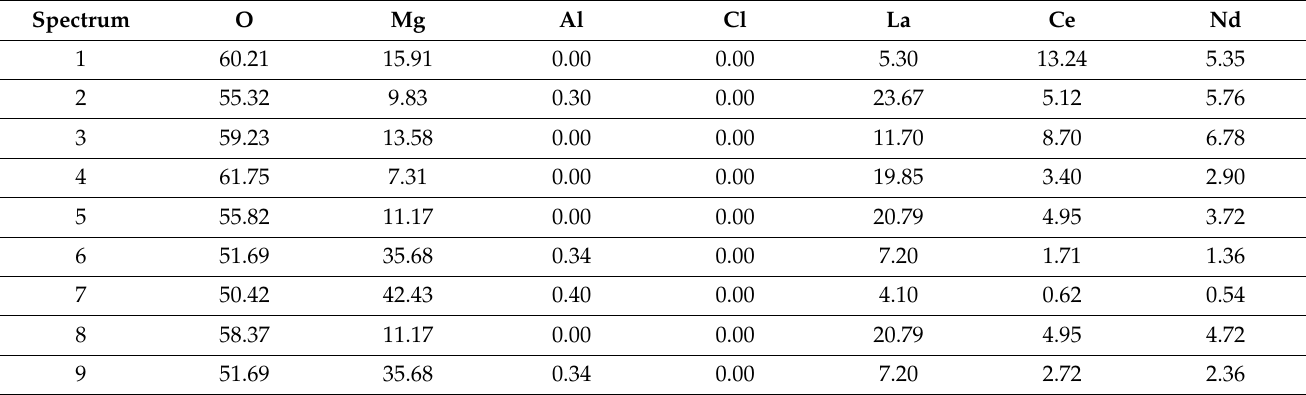
Figure 12. SEM images of the region (a) illustrated in Figure 11. The numbers illustrate the regions of the sample taken for the elemental analysis (see Table 3). Table 3. Data on the elemental analysis of the REM oxides pellet sampled from different points illustrated in Figure 12, atomic %.